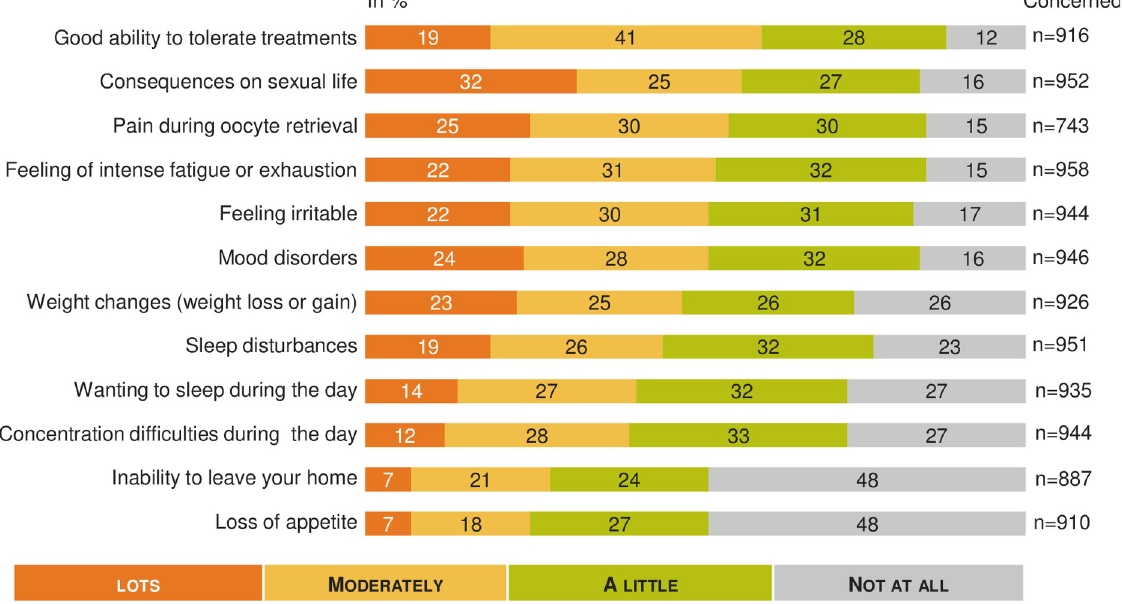
PLOS ONE | https://doi.org/10.1371/journal.pone.0238945 September 24,